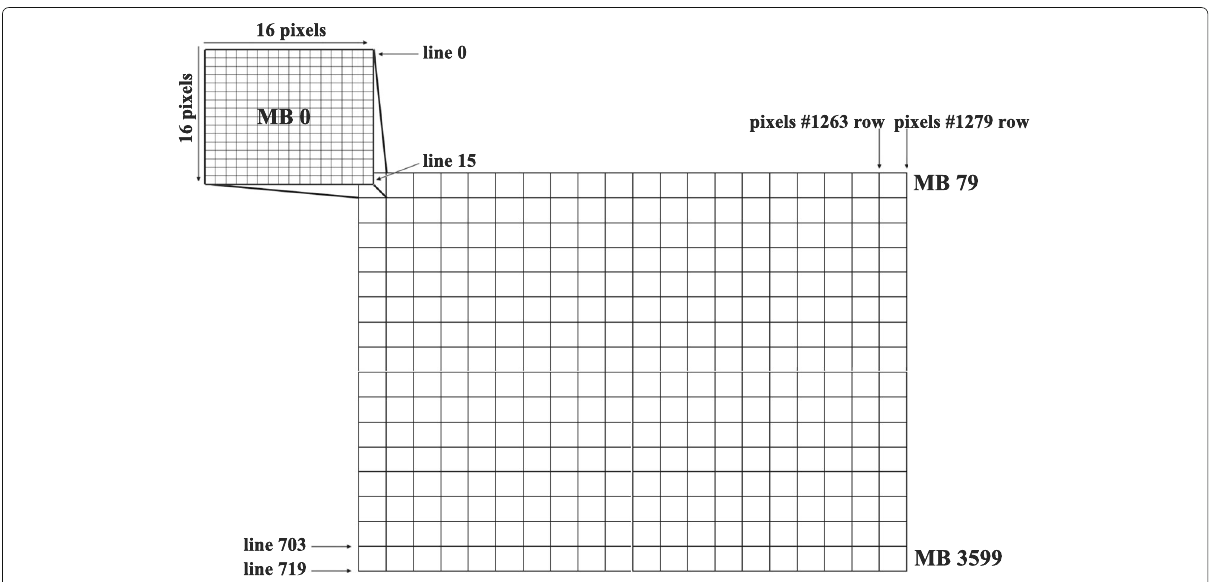
Fig. 7 Macroblock HD 720p frame subdivision